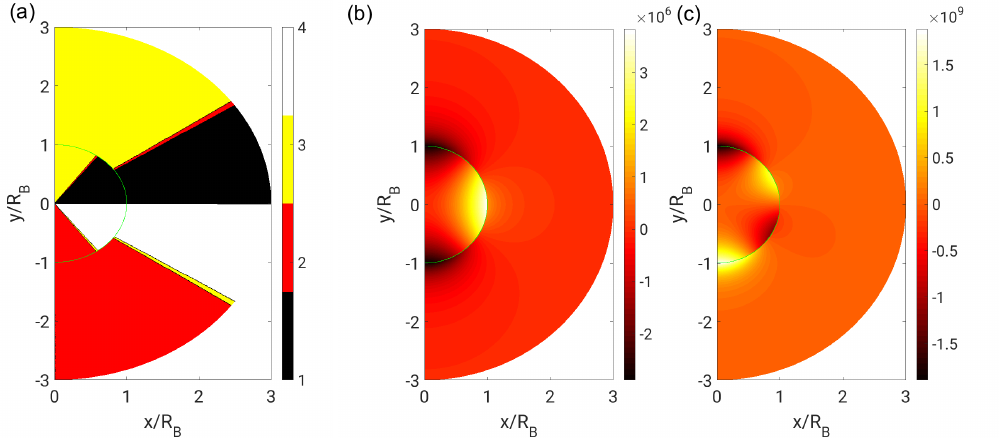
Figure 5. ( a ) Flow topologies; ( b ) second invariant Q ; and ( c ) third invariant R in the bubble case ( ξ = 0.0182) with far-field boundary conditions.